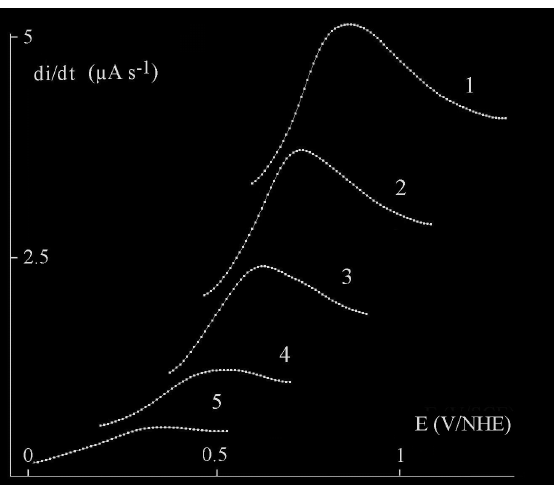
Figure 5. Derivative of anodic scans according to voltammograms. Scan number indicates peak of transient palladium complex lies to the adsorbed hydrogen current in Figure 4.